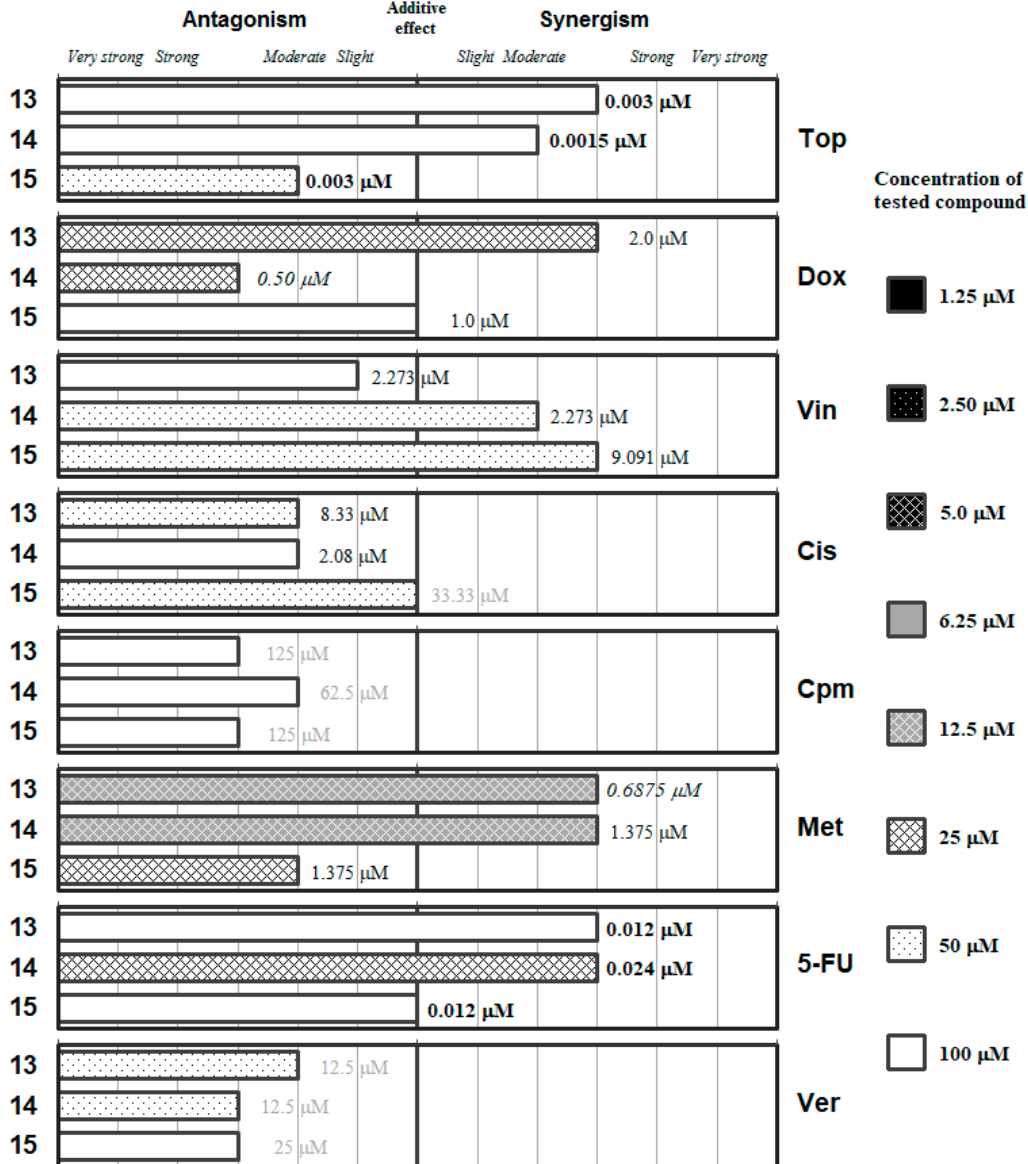
Figure 6. Interactions of the inorganic chalcogen cyanates ( 13 – 15 ) with a panel of anticancer drugs ( Top , Dox , Vin , Cis , Cpm , Met and 5 ‐ FU ) or an efflux pump inhibitor ( Ver ). Concentration of the tested compound is given according the legend; concentration of the anticancer drug is given in numbers inside the graph (in bold: below 0.1 μ M, in italics between 0.1 μ M and 1 μ M, and in grey above 10 μ